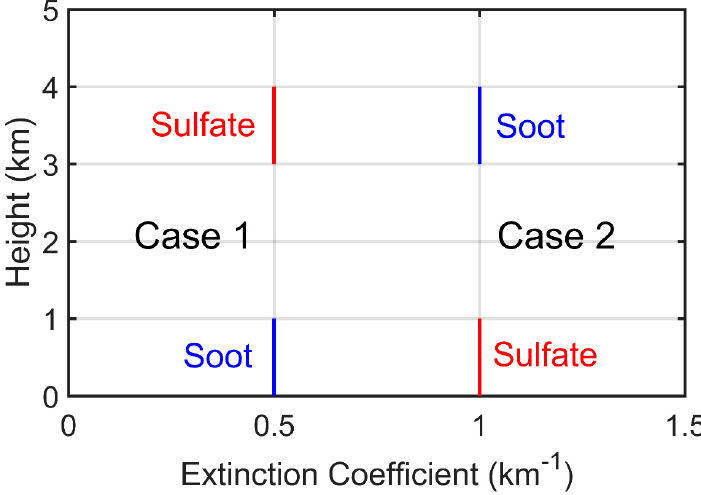
Figure 9. Assumed aerosol profile structures for the layered structure experiment, with two different aerosol types (sulfate and soot) located at different altitudes.